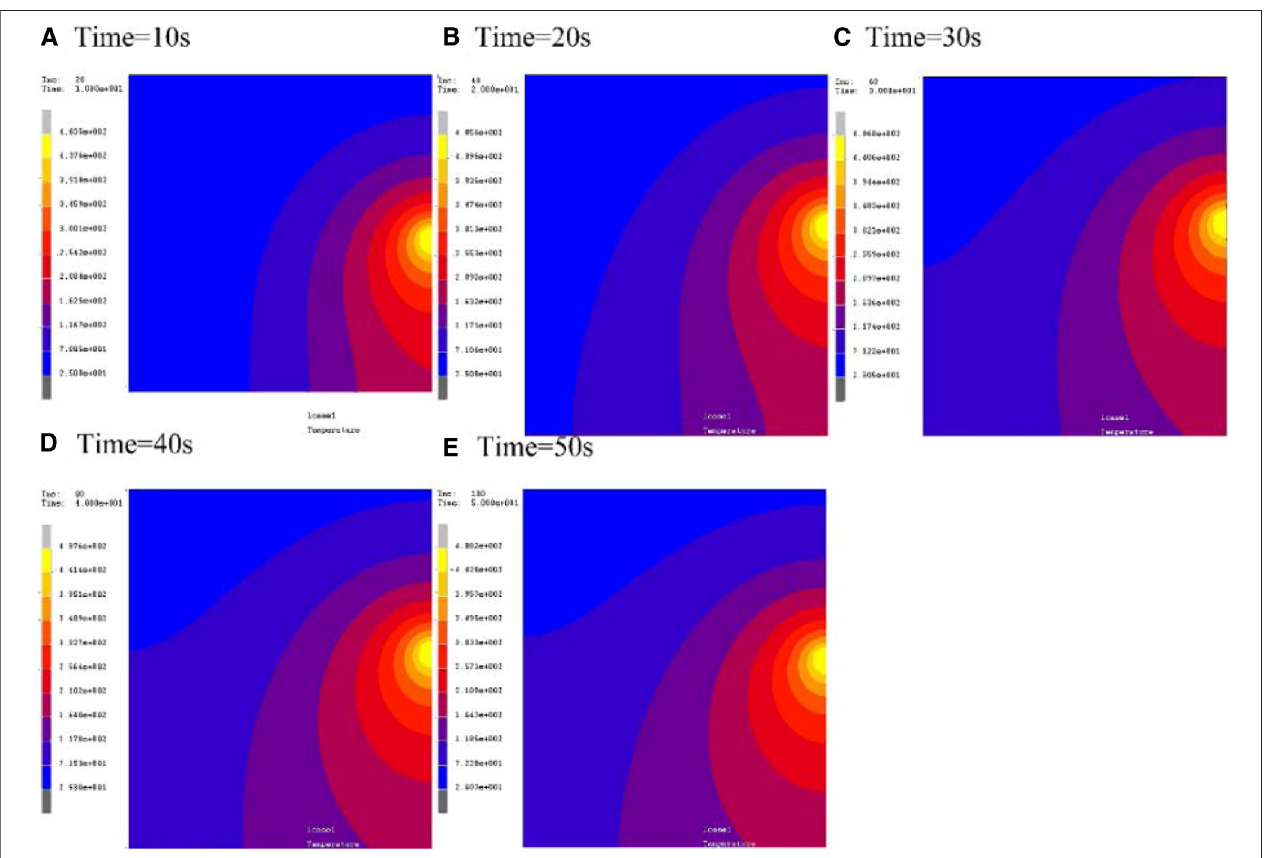
FIGURE4| Contouroftemperaturedistributionatdifferenttimeonthelowersurfaceoftheworkpiece(unit: ° C): (A) time (cid:1) 10 s, (B) time (cid:1) 20 s, (C) time (cid:1) 30 s, (D) time (cid:1) 40 s, (E) time (cid:1) 50 s.